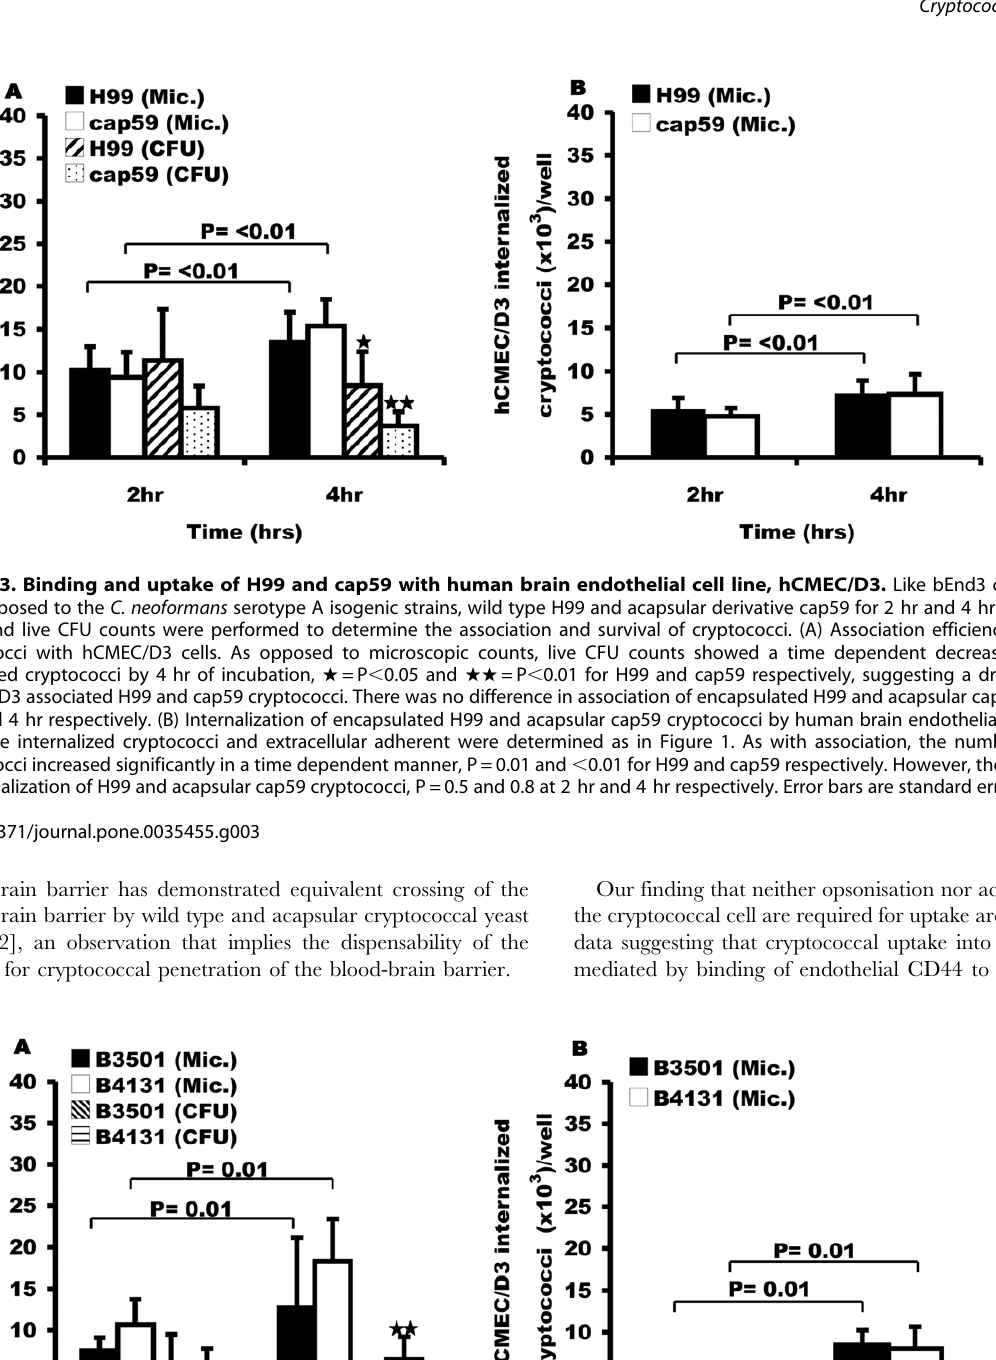
Figure 4. Binding and uptake of B3501 and B-4131 with human brain endothelial cell line, hCMEC/D3. HCMEC/D3 cells were exposed to C. neoformans serotype D wild type B3501 and its isogenic acapsular mutant B4131 for 2 hr and 4 hr at 37 u C. Microscopic and live CFU counts were performed to determine the association and survival of cryptococci. (A) Association efficiency of B3501 and B4131 cryptococci with hCMEC/D3 cells. Like the H99-cap59 pair, live CFU counts showed a time dependent decrease in the number of associated cryptococci by 4 hr of incubation, w =P , 0.01, ww =P , 0.01 for both B3501 and B4131. There was no difference in association by encapsulated B3501 and acapsular B4131, P- value= . 0.05 at 2 hr of incubation. However, B4131 was significantly more associated, P=0.02 (Microscopy) and , 0.01 (CFU) by 4 hr of incubation. (B) Internalization of encapsulated B3501 and its acapsular mutant derivative B4131 by hCMEC/D3 cells determined by fluorescence microscopy (Mic). The number of phagocytosed cryptococci increased significantly in a time dependent manner, P=0.01 for both strains. However, there was no difference in internalization of B3501 and B4131, P=0.5 and 0.2 at 2 hr and 4 hr respectively. Error bars are standard error of the mean, n=6 repeats.